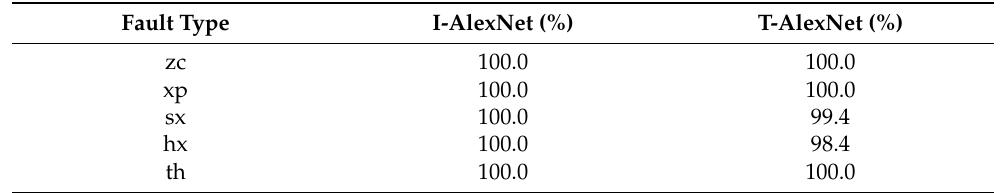
Table 4. Precision of I-AlexNet and T-AlexNet for different fault types.